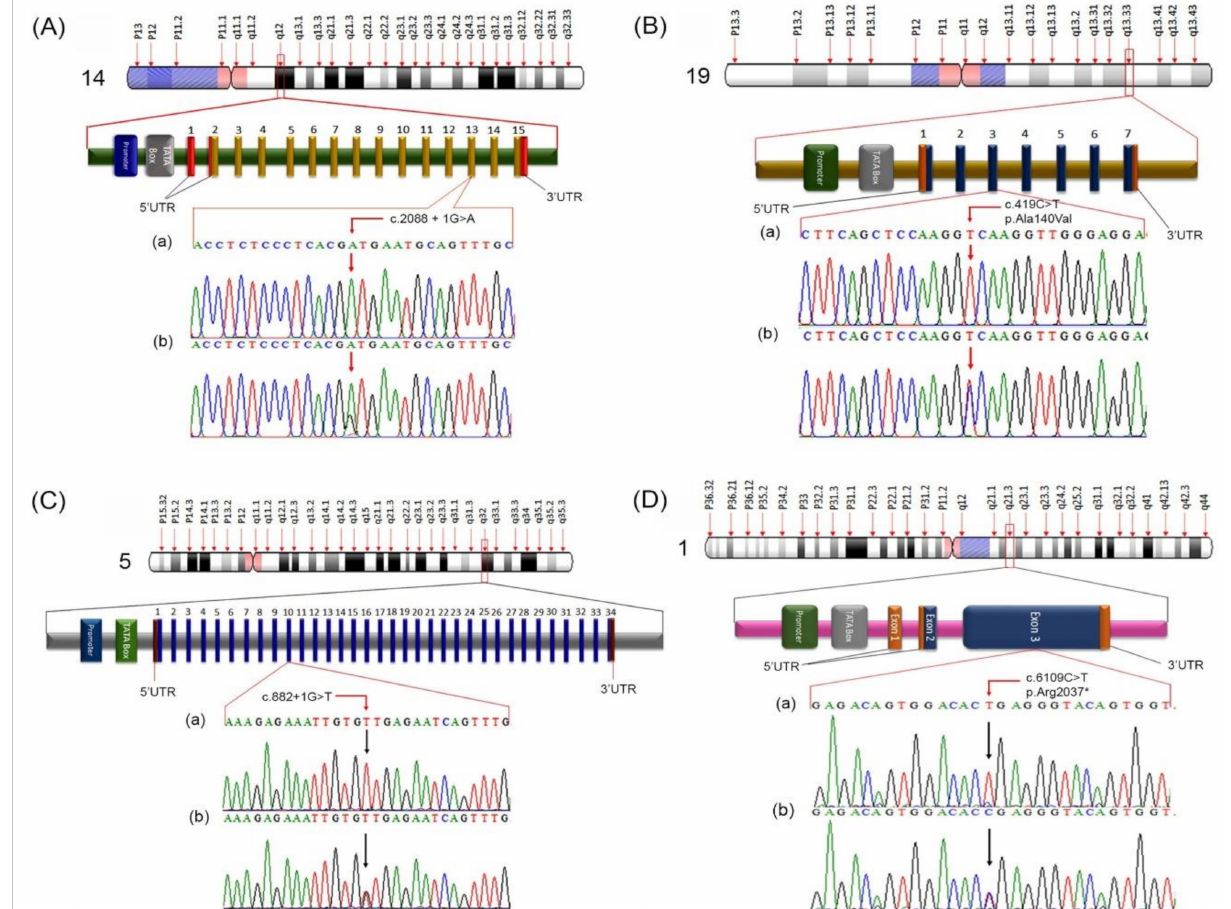
Figure 2. Chromosomal location, hypothetical structure and sequence chromatogram of TGM1 , SULT2B1 , SPINK5 , and FLG variants, showing the positions of genetic alterations in the in the present study. ( A ) Chromosomal location and hypothetical structure of TGM1 containing all 15 exons along with sequence analysis of TGM1 variant. ( a ) shows a partial sequence of exon-13 of TGM1 in an affected member (IV-2) with novel splice site mutation involving a homozygous G → A transition in the splice donor site of intron 13 (c.2088 + 1G > A) and ( b ) shows sequence of an unaffected heterozygous carrier (III-2) in Family A. ( B ) Panel B presents chromosomal location and hypothetical structure of SULT2B1 gene with its six exons. ( a ) shows partial sequence of exon-3 of SULT2B1 in an affected (III-2) and ( b ) in an unaffected member (II-4) of Family